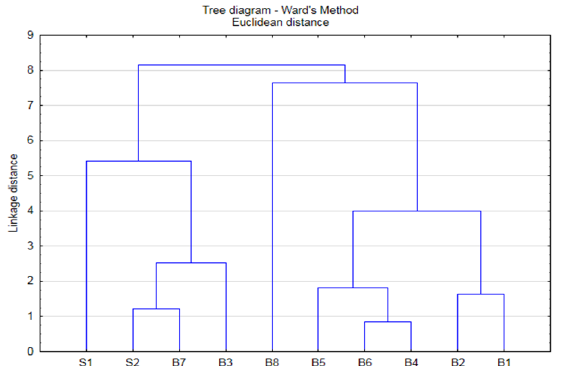
Figure 8. Grouping results in 2018.